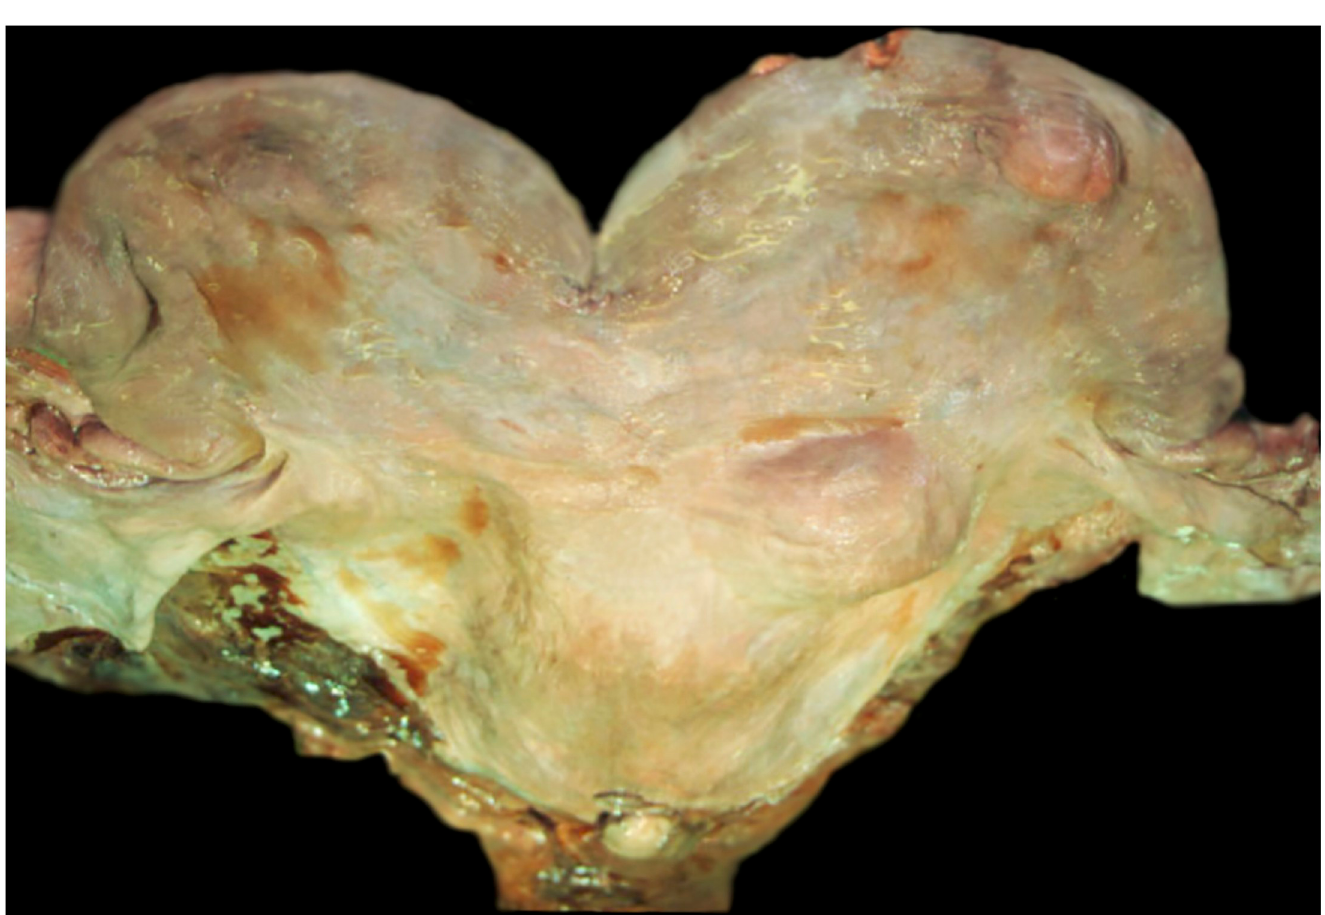
Fig 8. Multiple leiomyomas associated with the fallopian tube, uterus and mesovarium. This lesion was identified in adult transient female (ID# 20040503).